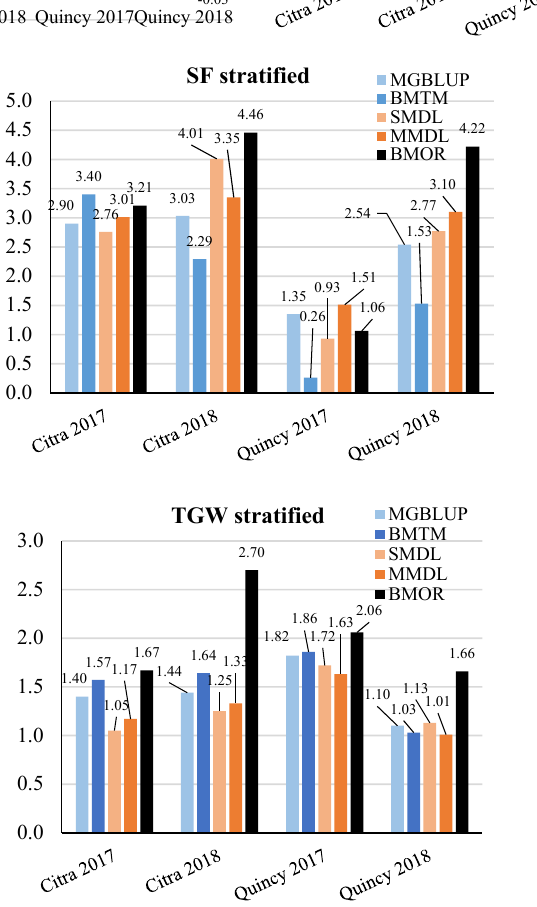
Figure 8. Response to selection for GY (ton ha − 1 ), HI (%), SF (grains / g cha ff weight), and TGW (g) with population stratified. GY, grain yield; HI, harvest index; SF, spike fertility; TGW, thousand grain weight. Response to selection for each environment was presented and labeled for each trait. Statistical models were colored in light blue and blue, while the DL models were colored in light orange and orange. The BMOR model was colored in black.